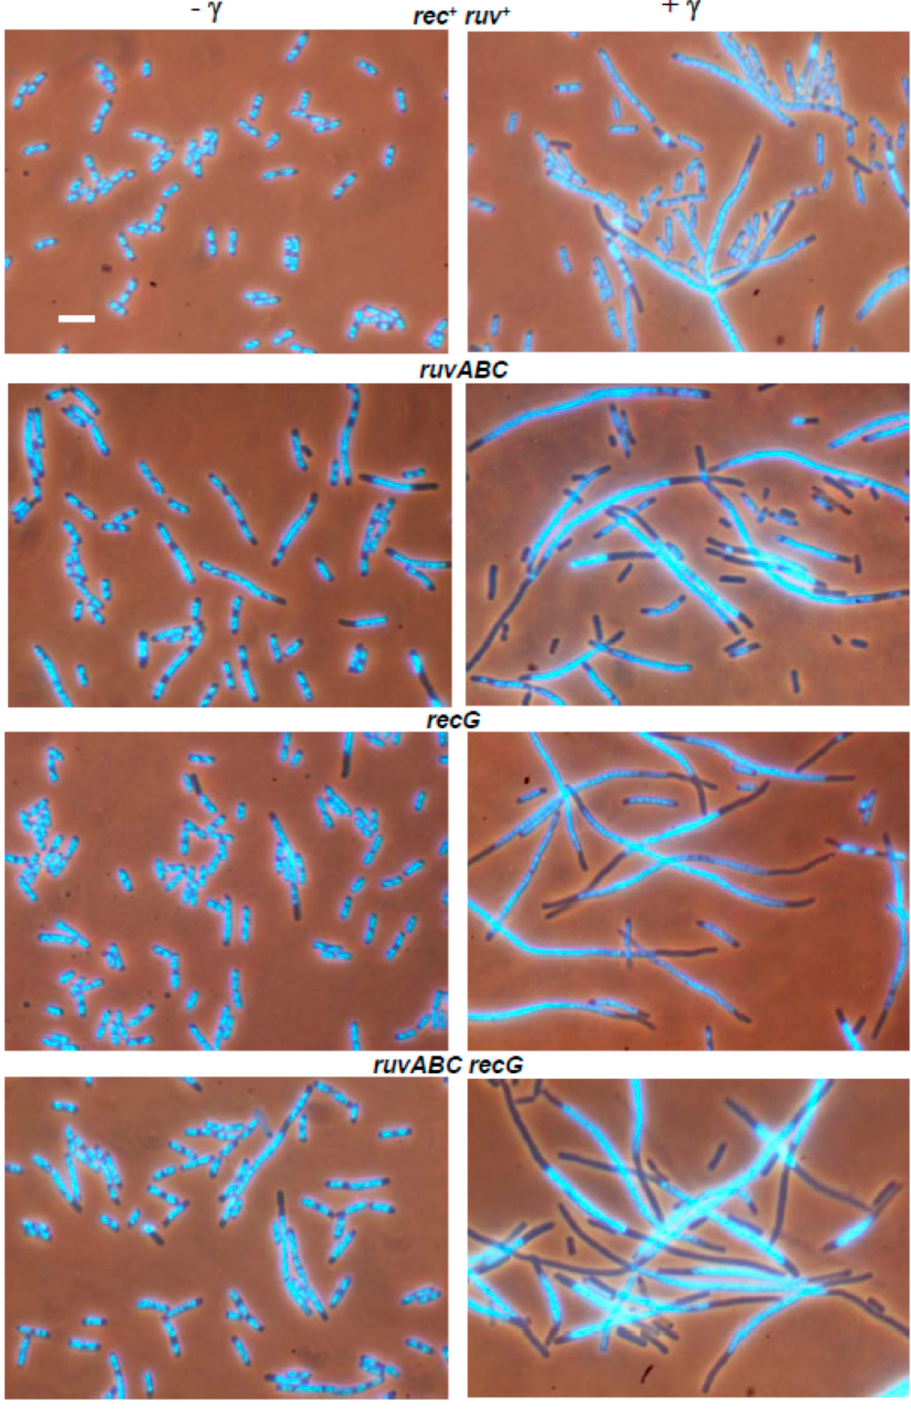
Figure 6. Chromosome segregation and cell division defects in wild-type, ruvABC , recG and ruvABC recG mutants after exposure to γ -irradiation. Exponentially growing cells, either non-irradiated (left side of the panel) or irradiated with 100 Gy of γ -irradiation and then grown for two hours (right side of the panel), were fixed with osmium tetroxide, stained with DAPI and observed under a fluorescence microscope. Bar, 5 μ m.